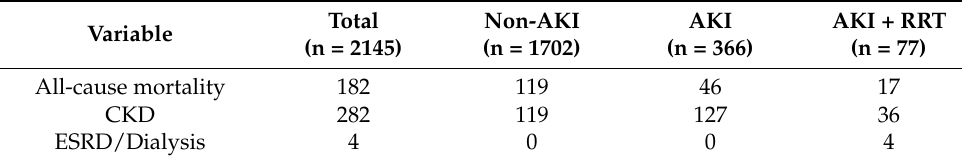
Table 2. Number and percentage of event of outcomes.